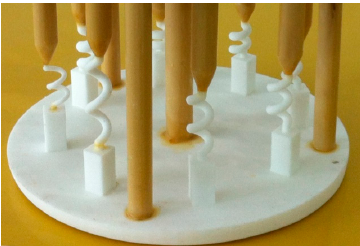
Figure 2. White wax mold fabricated by 3D printing.